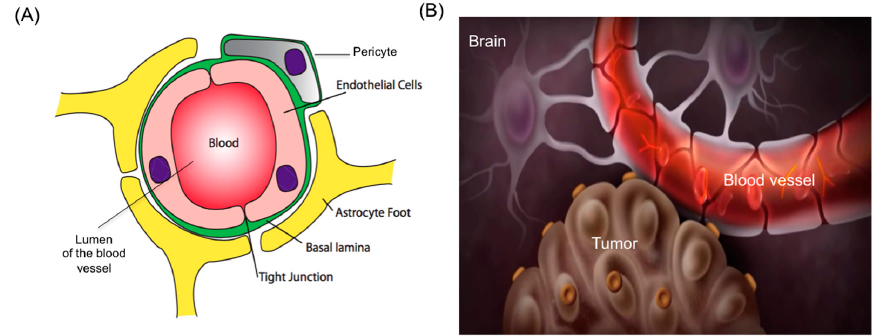
Figure 1. ( A ) Schematic illustration of the blood–brain barrier in cross section maintained by brain capillary endothelial cells and astrocytes via tight junctions; ( B ) Brain architecture illustration along with blood vessels and tumor.